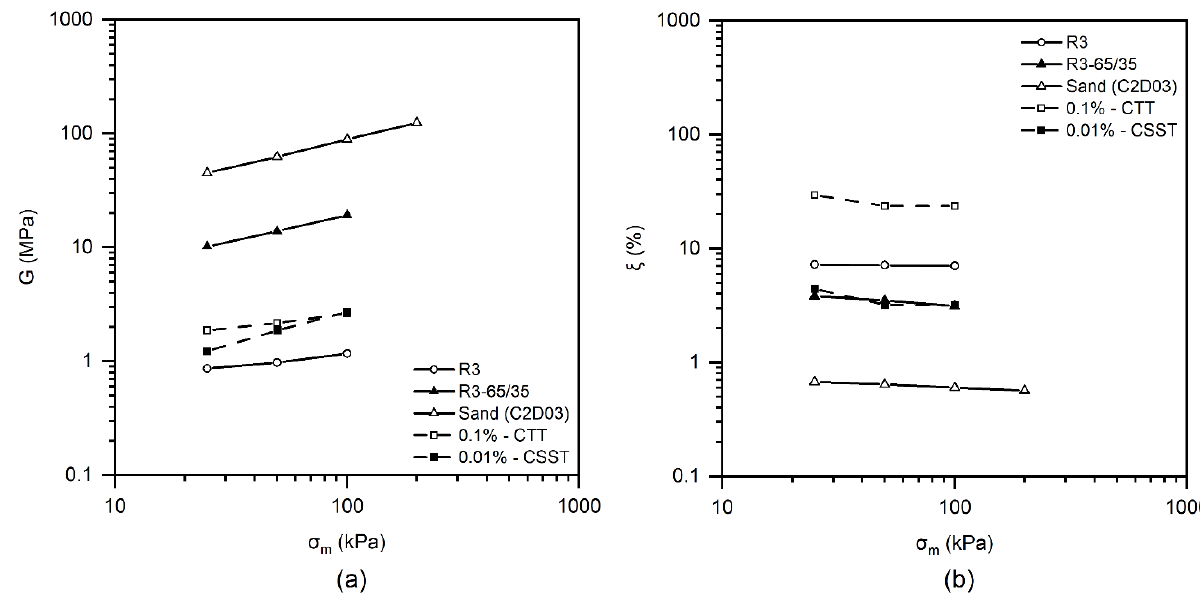
Figure 11. Relation between vertical consolidation stresses and ( a ) shear moduli and ( b ) damping ratios.